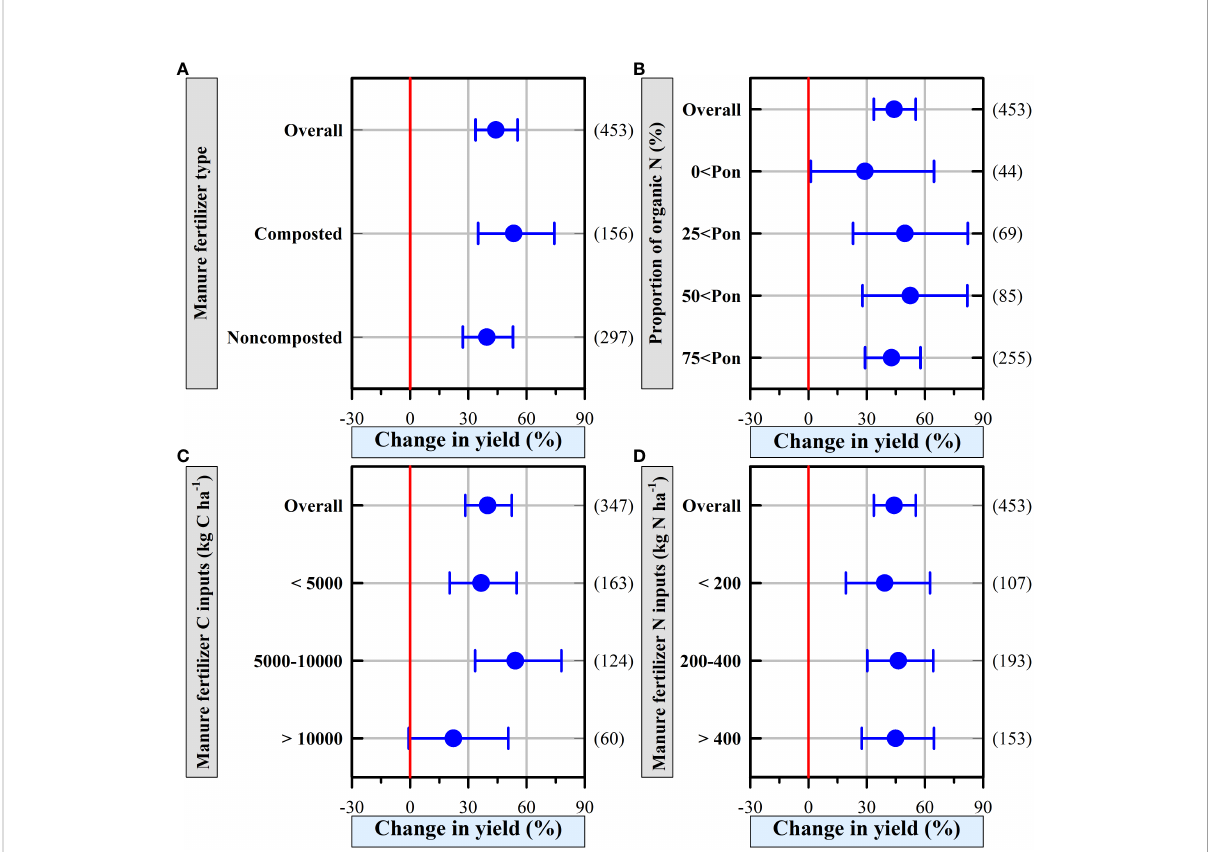
FIGURE 3 The effects of organic fertilizer properties (A) manure fertilizer type, (B) proportion of organic N, (C) manure fertilizer C inputs, and (D) manure fertilizer N inputs on greenhouse vegetable yield. The numbers of observations are shown right parentheses. The blue horizontal bars represent the 95% con fi dence intervals (CIs). If the CI does not overlap with 0 red line, which indicates a signi fi cant effect at P <